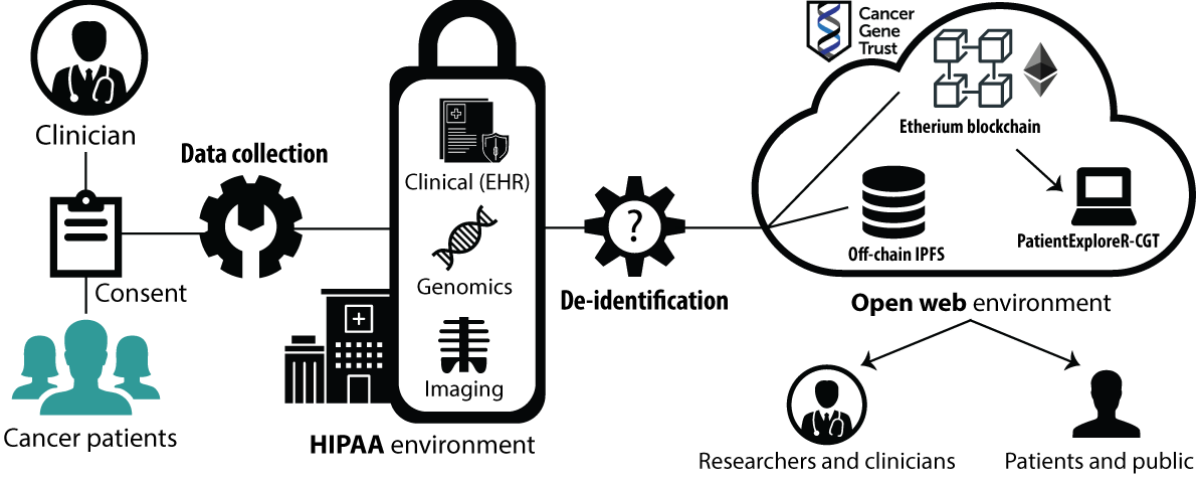
Figure 1. Workflow and pipeline for Cancer Gene Trust. EHR: electronic health record; HIPAA: Health Insurance Portability and Accountability